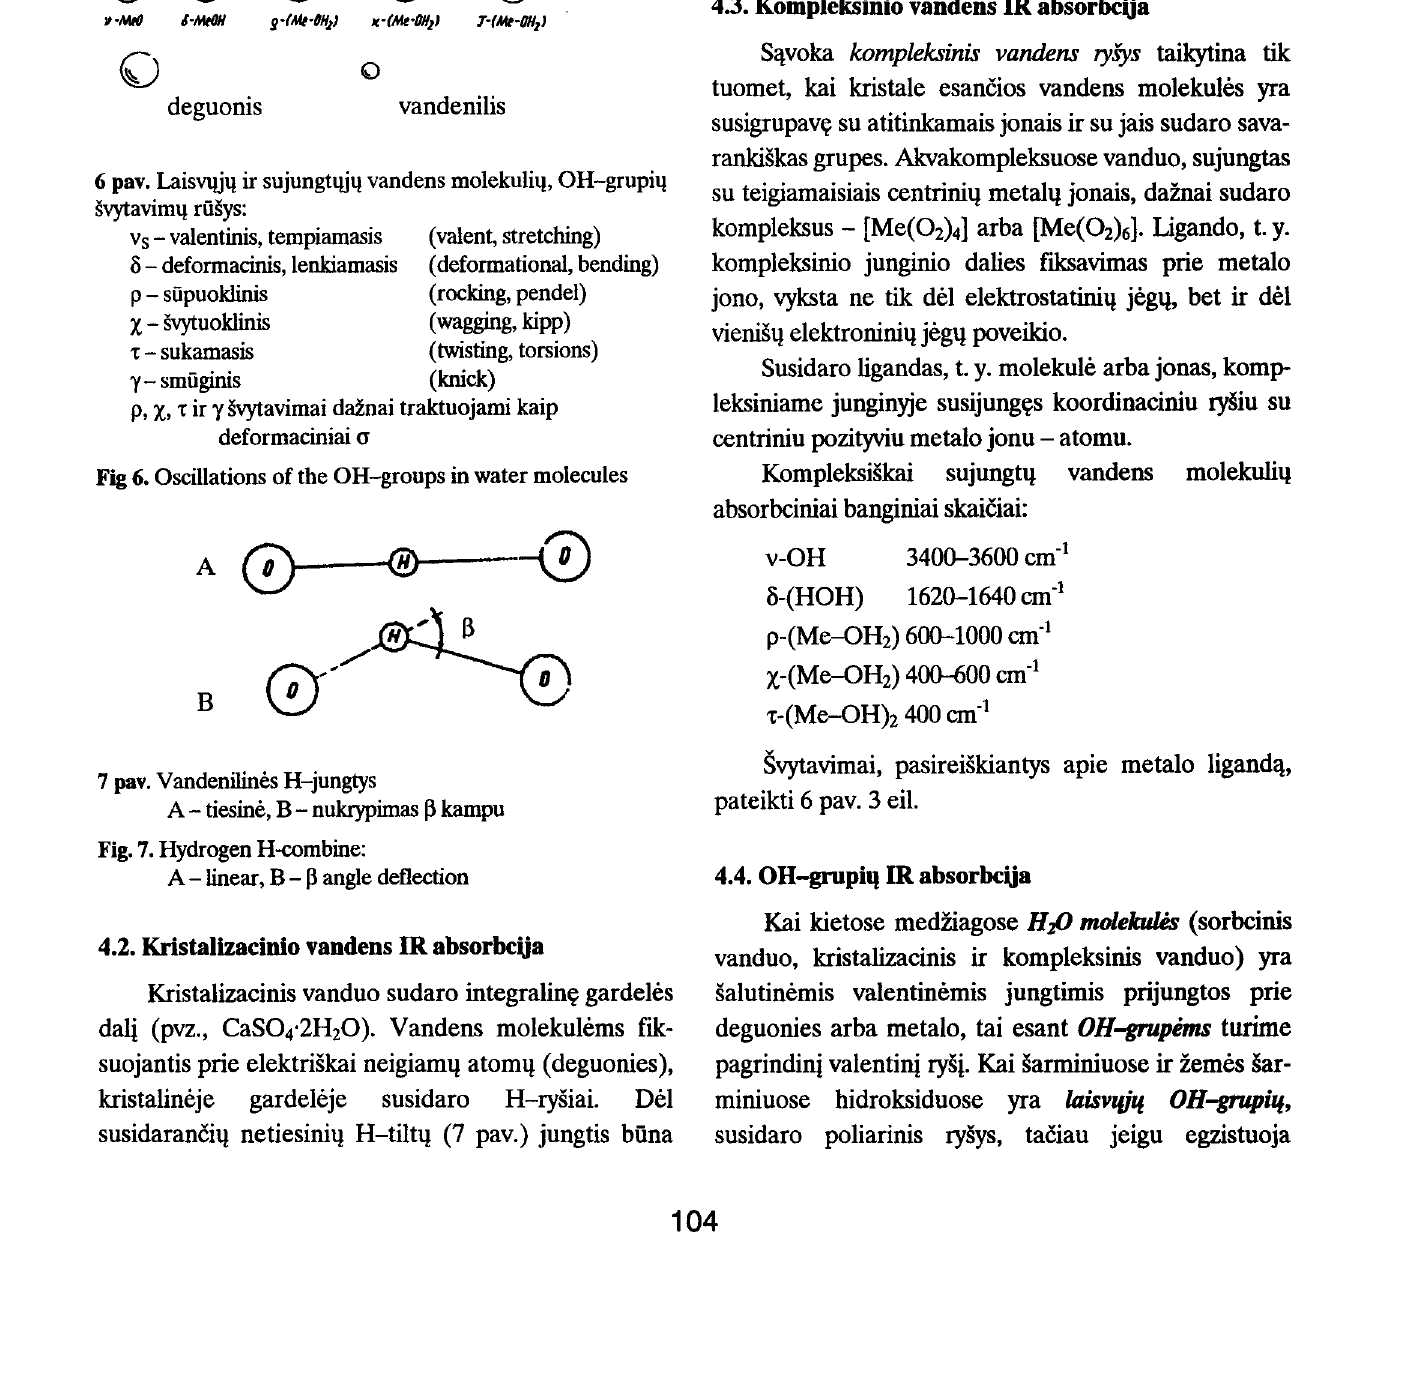
Fig 6. Oscillations of the OR-groups in water molecules